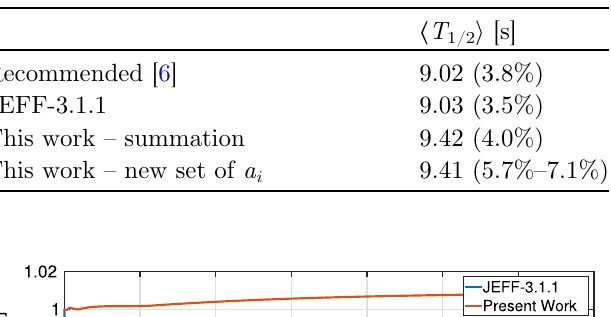
Table 2. Mean DN precursors ’ half-life.